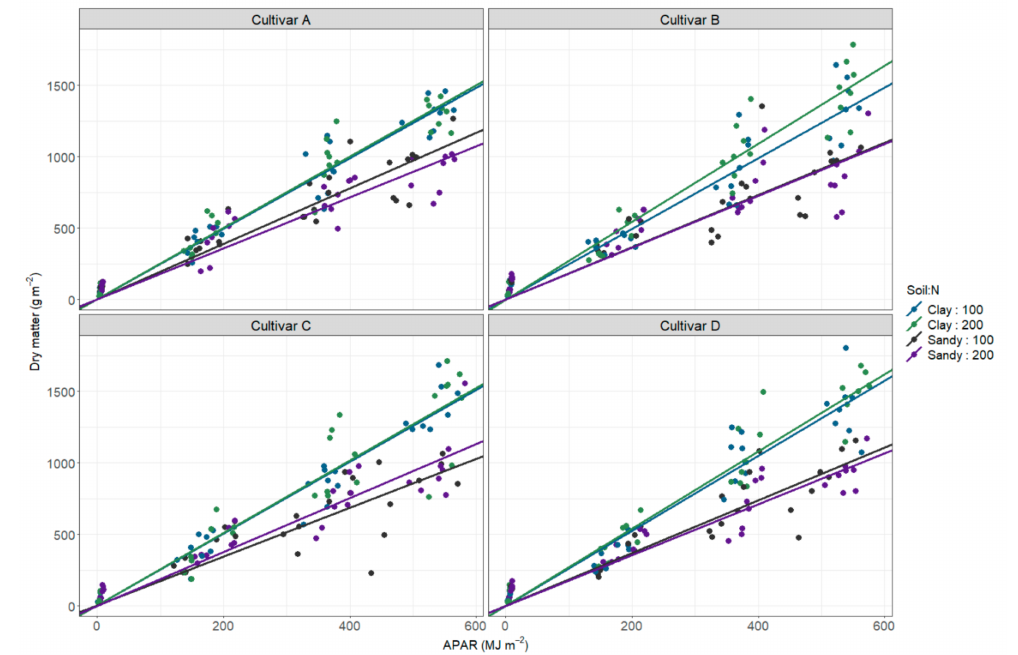
Figure 3. Linear regressions between aboveground dry matter (DM) and accumulated intercepted photosynthetic active radiation (APAR) for each nitrogen level and soil type across the four wheat cultivars A, B, C and D (Quintus, Scirocco, Økilde and Hovsa, respectively). The slopes of the regression lines represent the radiation use e ffi ciency (RUE). The slopes were estimated from a linear mixed model with a forced intercept through the